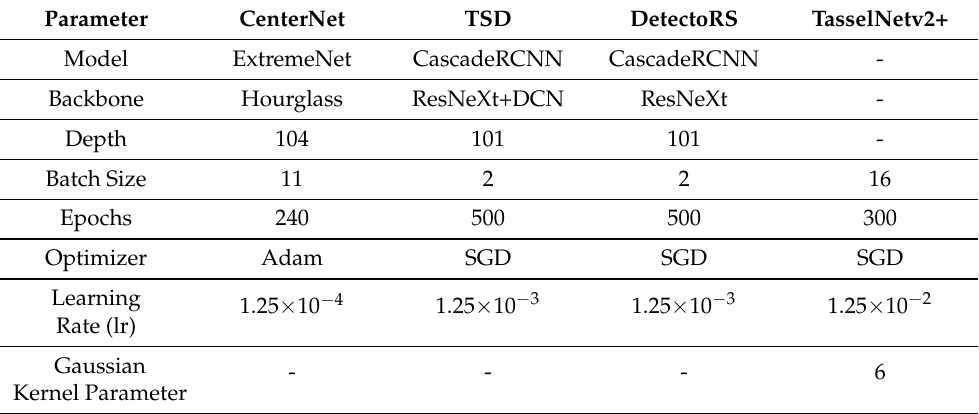
Table 1. Parameter